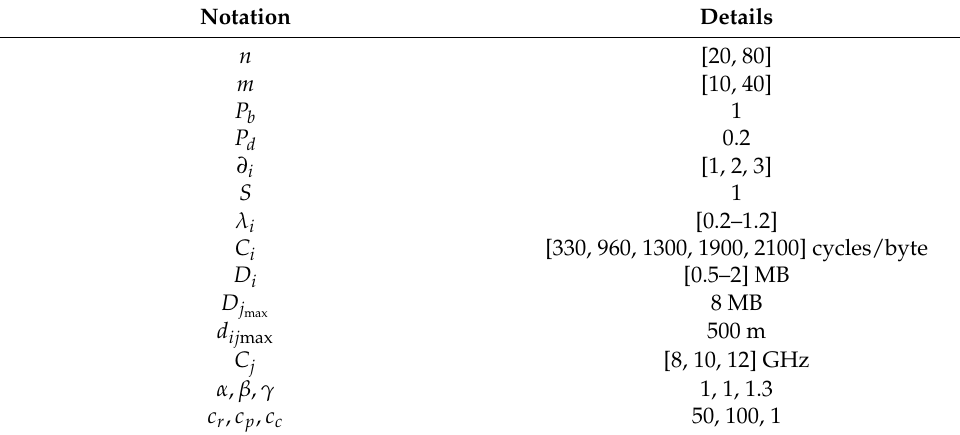
Table 2. Summary settings of key notations.